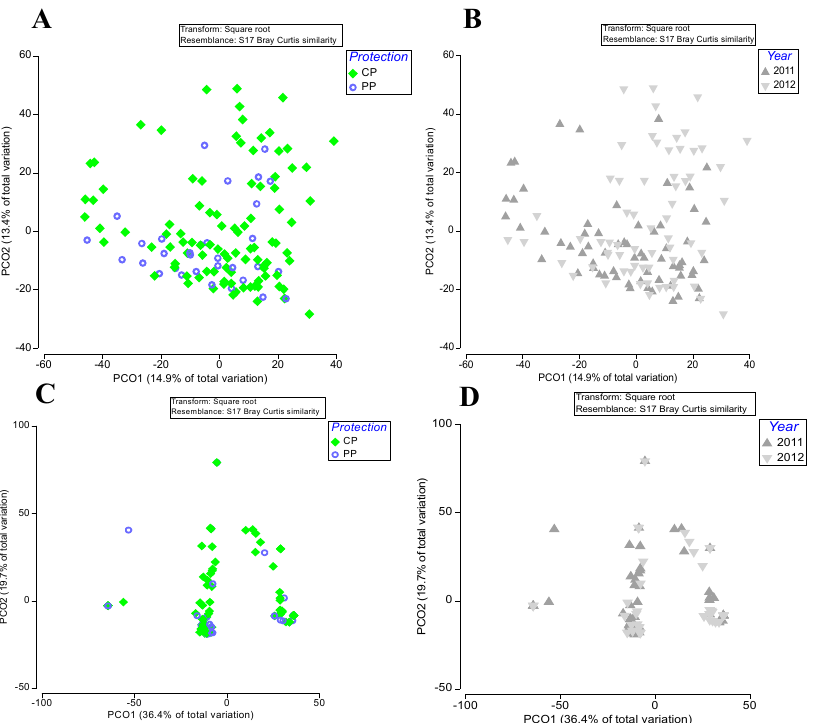
Figure 2. Principal Coordinates Analyses (PCO) of fish community structure (non-cryptic, ( A , B ); cryptic, ( C , D )) regarding the factors “Protection” (partially protected areas (PP) and adjacent control areas, complementary protection areas (CP); ( A , C ) plots) and “Year” (2011 and 2012; ( B , D ) plots) in the northern marine PNSACV.